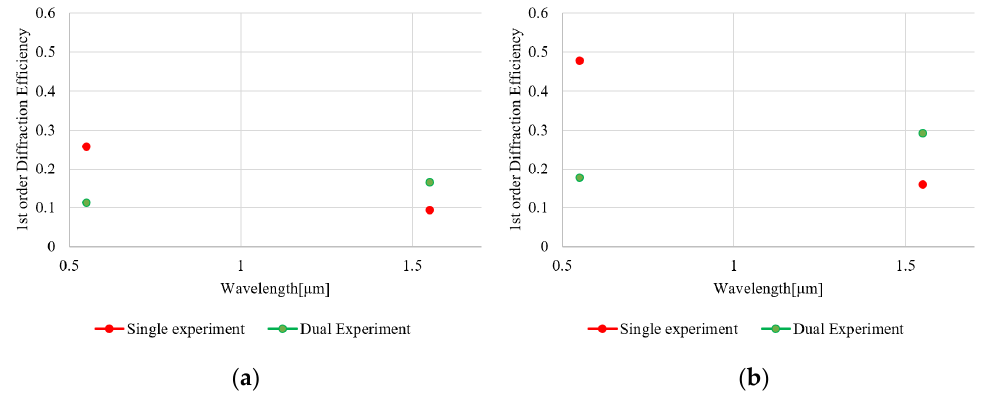
Figure 4. A +1-order diffraction efficiency of CGH for 10 pixels/period with ( a ) binary- and ( b ) staircase-approximated blazed grating profiles. At wavelength of 532 nm, conventional single modulation has higher DE. At 1550 nm, dual-phase modulation increased the DE by a factor of 2. At the wavelength of 532 nm, single modulation exhibits a higher diffraction efficiency (DE) compared to the dual modulation for both binary- and staircase- approximated blazed CGHs. The result indicates that the dual modulation architecture exhibits more loss, as expected. In contrast, at a wavelength of 1550 nm, the dual modulation architecture outperforms the single modulation, for which the phase